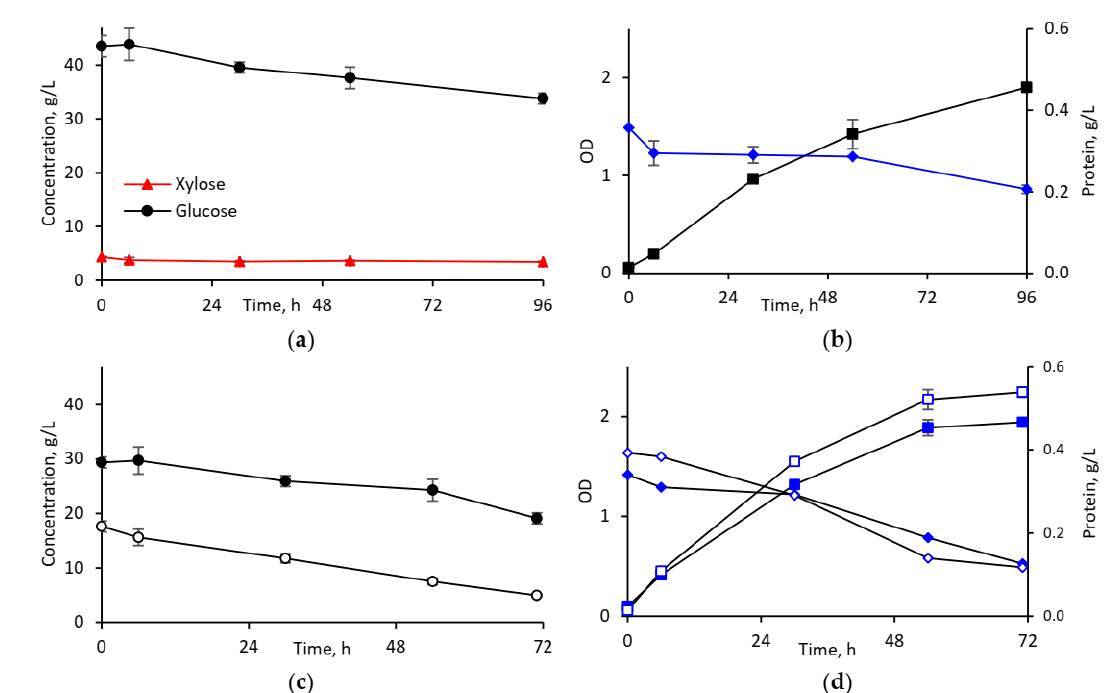
Figure 2. Dynamics of the cultivation of B. atrophaeus BU4 in glucose-based synthetic media: ( a ) consumption of glucose (circles) and xylose (triangles) in SM-G45; ( b ) OD (squares) and protein (rhombs) consumption in SM-G45; ( c ) glucose consumption in SM-G30 (filled circles) and SM-G15 (empty circles); ( d ) OD (squares) and protein consumption (rhombs) in SM-G30 (filled symbols) and SM-G15 (empty